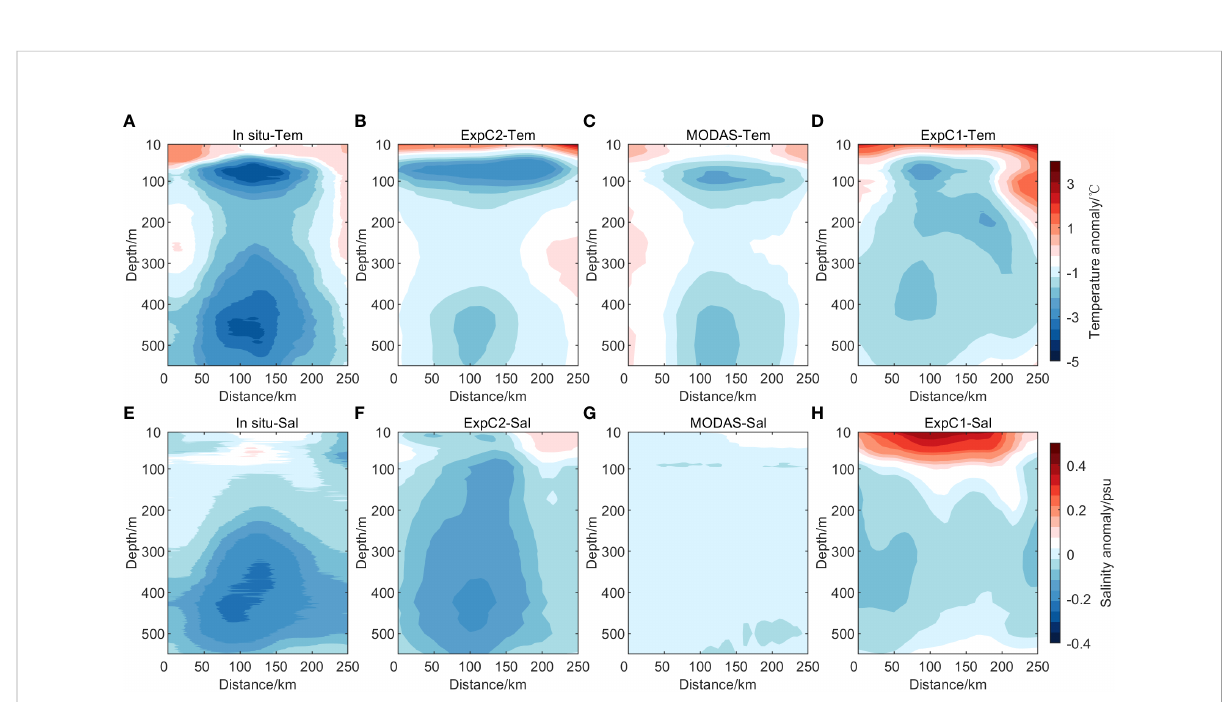
FIGURE 11 The section structure of the temperature and salinity anomaly at the position of the red dot in Figure 10. Top: temperature anomaly values; bottom: salinity anomaly values. (A, E) in-situ survey data, (B, F) the experiment results of assimilating the synthetic T/S observations, (C, G) the MODAS data of the National Marine Data Center, (D, H) the experiment results of assimilating the satellite